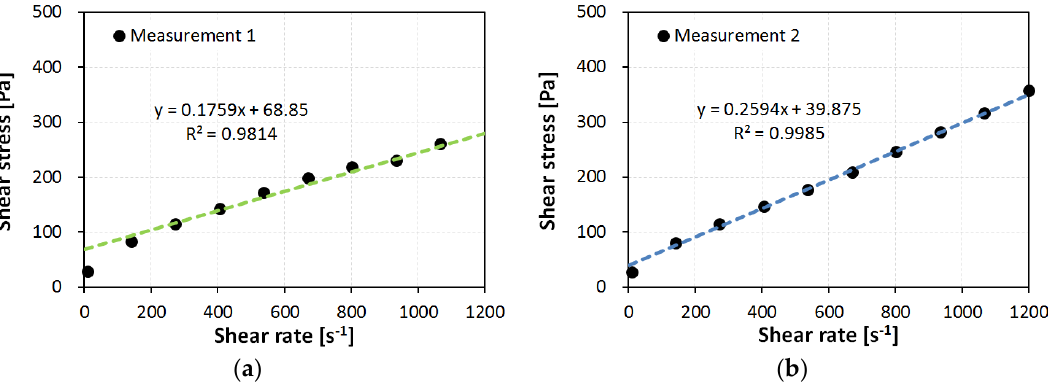
Figure 5. Down step for flow curve of sample WB35 ‐ PCE0.2 under atmospheric pressure; ( a ) Measurement 1 under atmospheric pressure and ( b ) Measurement 2 under a high pressure.